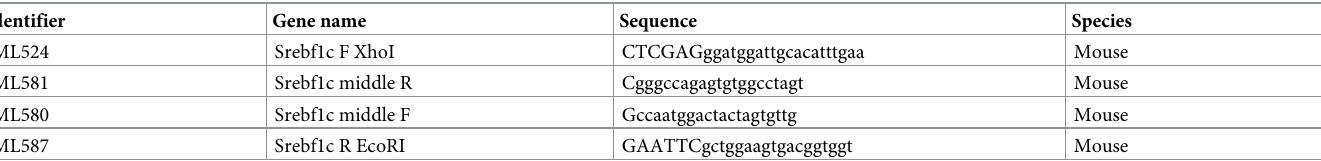
Table 2. List of cloning